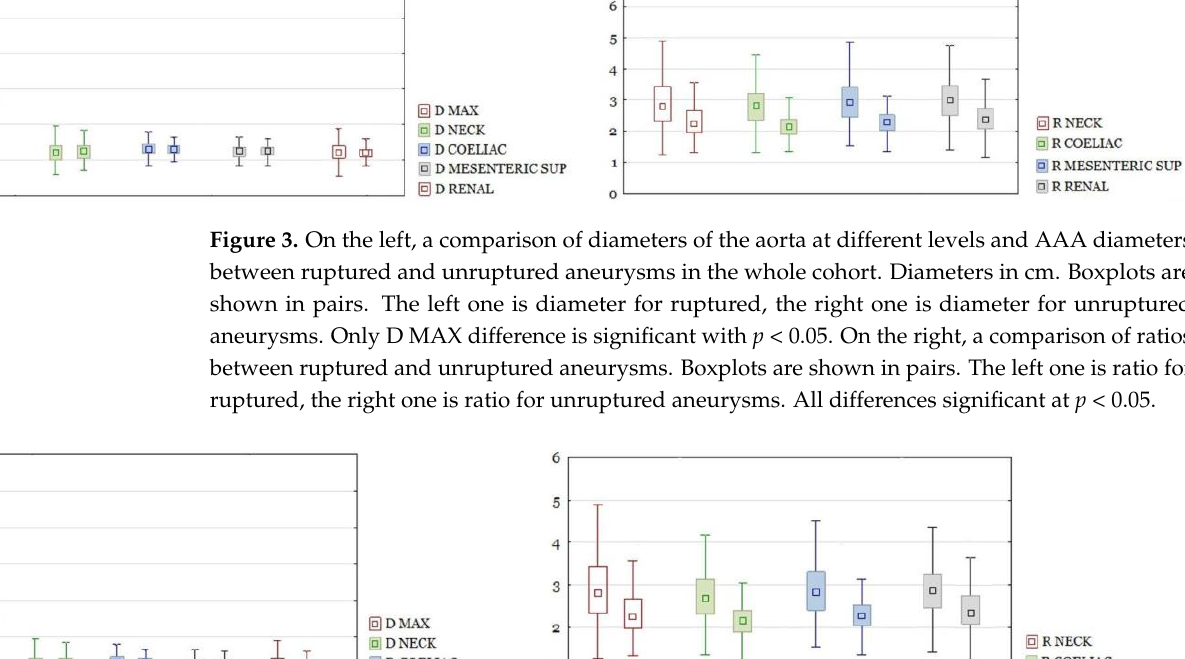
Figure 3. On the left, a comparison of diameters of the aorta at different levels and AAA diameters between ruptured and unruptured aneurysms in the whole cohort. Diameters in cm. Boxplots are shown in pairs. The left one is diameter for ruptured, the right one is diameter for unruptured an- eurysms. Only D MAX difference is significant with p < 0.05. On the right, a comparison of ratios between ruptured and unruptured aneurysms. Boxplots are shown in pairs. The left one is ratio for ruptured, the right one is ratio for unruptured aneurysms. All differences significant at p < 0.05.